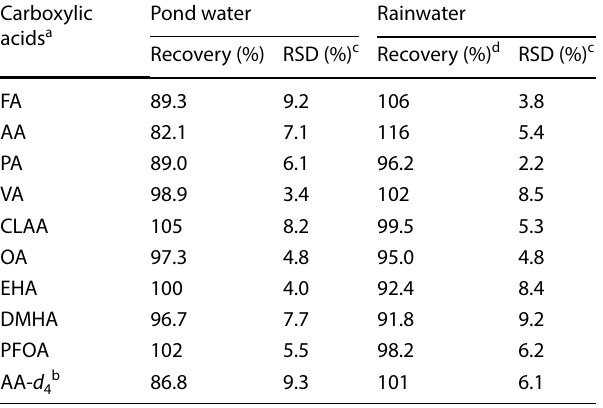
Table 4 Recovery test from environmental